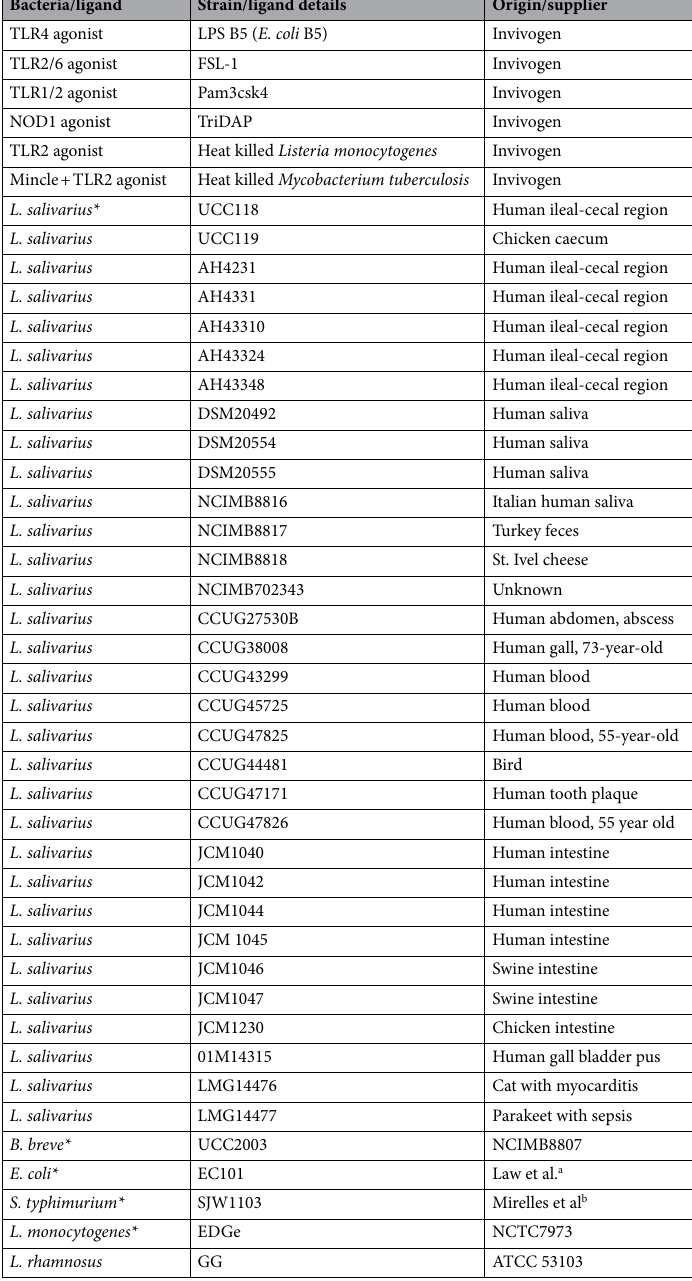
Table 1. List of bacterial strains and ligands used in this study. The table details Toll Like Receptor (TLR) ligands and their source of origin as well as bacteria species, strains and their source of origin, where known. *L. salivarius - Lactobacillus salivarius , B. breve- Bifidobacterium breve , E. coli- Escherichia coli, L. rhamnosus - Lactobacillus rhamnosus , S. typhimurium - Salmonella typhimurium, L. monocytogenes- Listeria monocytogenes. a Law et al. 1995. b Mireles et al.